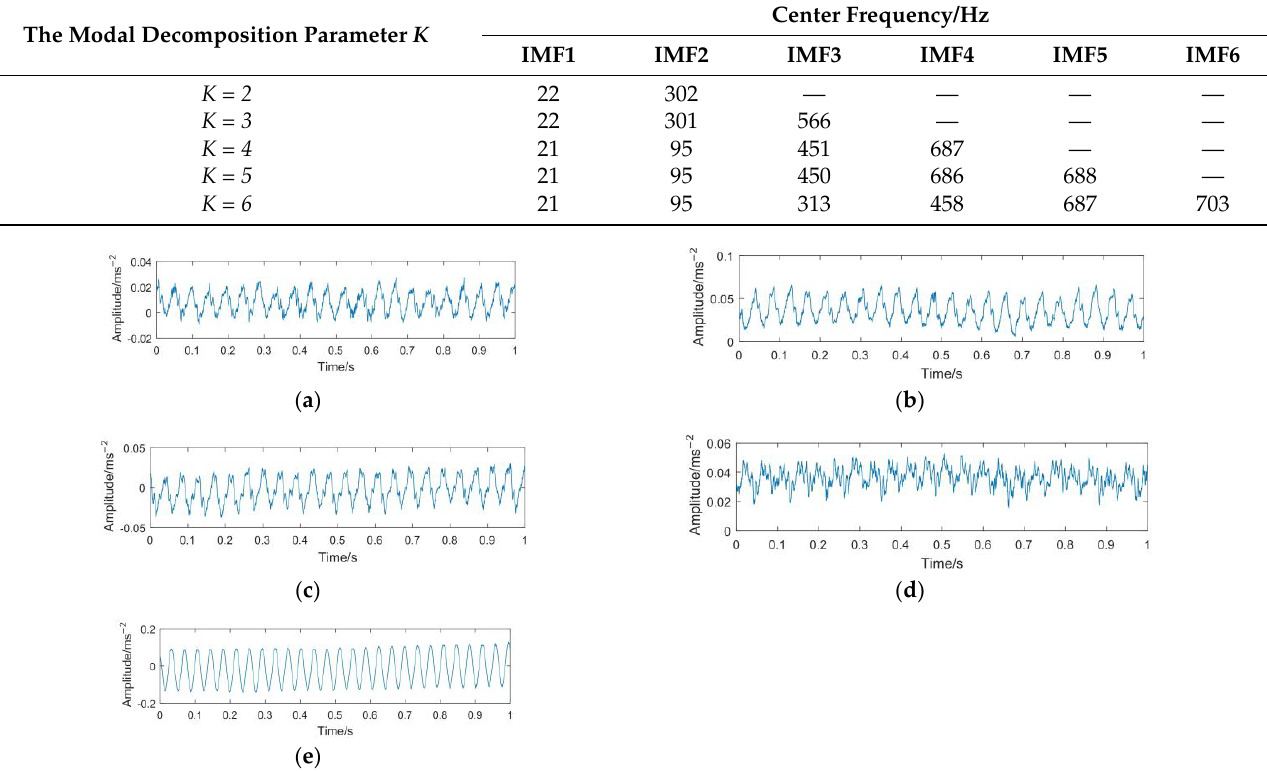
Figure 6. The time-domain waveform of a group of rotor signals: ( a ) Nor, ( b ) BBLF, ( c ) MF, ( d ) IF, ( e )